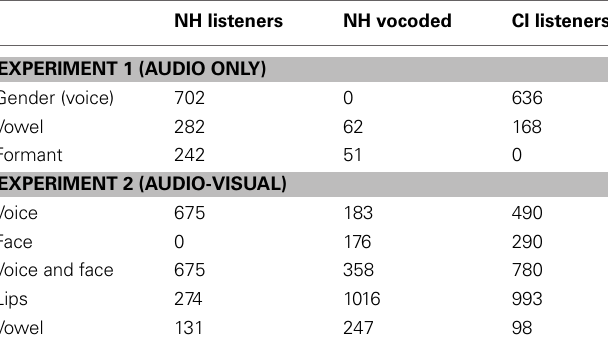
Table 6 | Difference (in Hz) between / opposing levels of each context tested in both experiments (modeled from GLMM